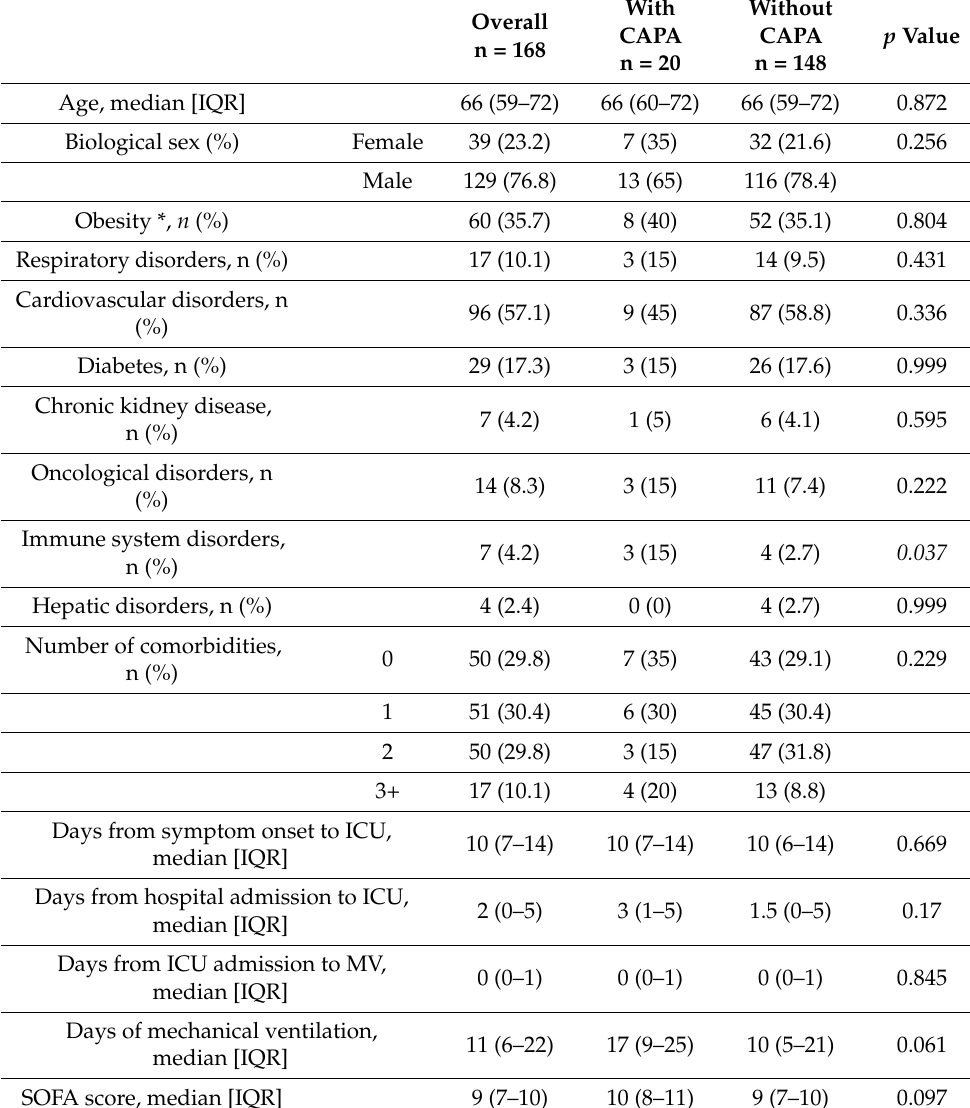
Table 1. Characteristics of the study